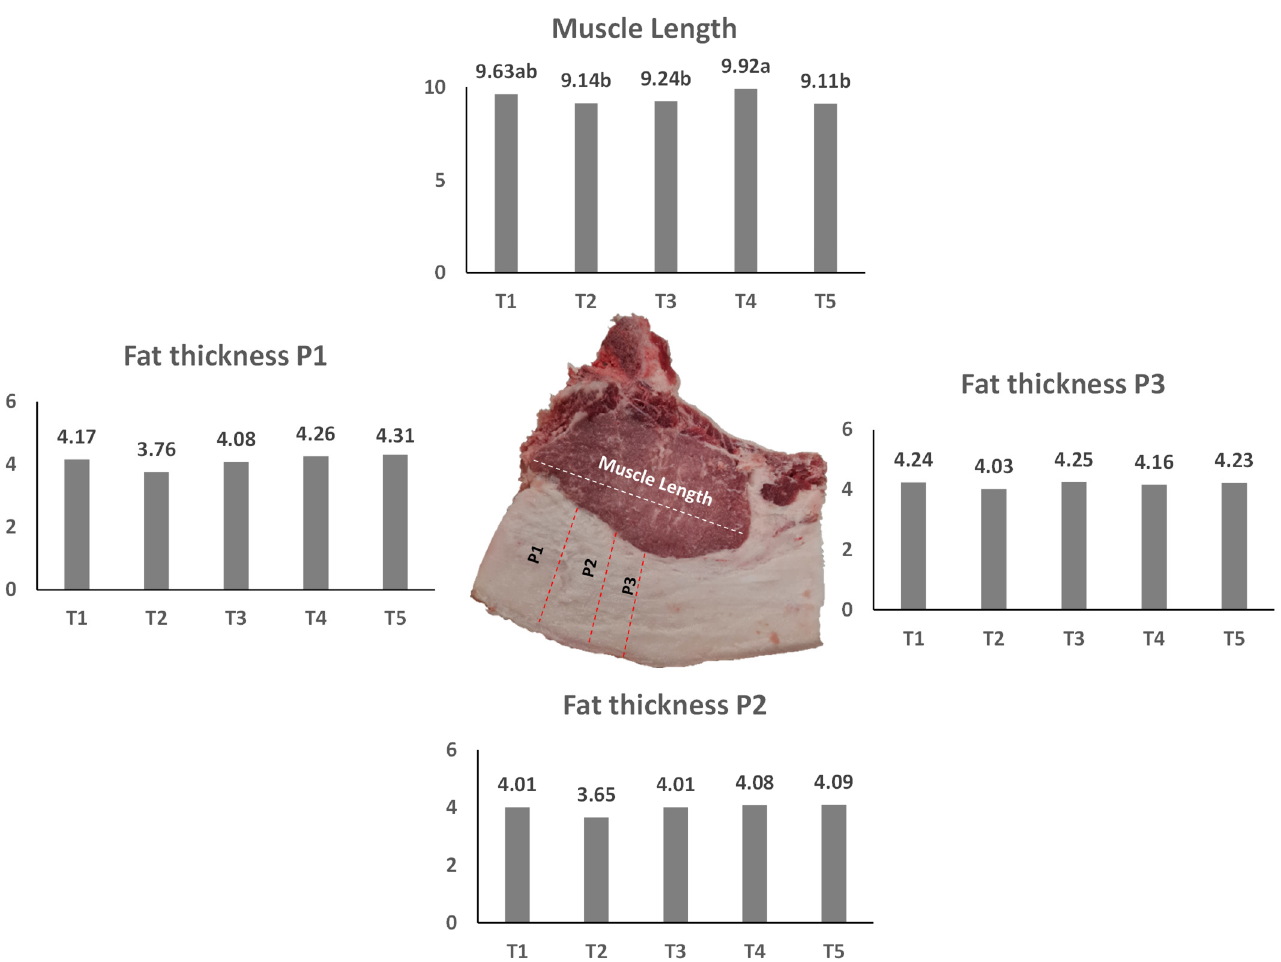
Figure 3. Muscle and backfat measurements at the 13th and 14th rib of Bísaro carcass (P1—4.5 cm from the dorsal midline; P2—6.5 cm from the dorsal midline; P3—8 cm from the dorsal midline). Mean values with different lowercase letters within the same treatment are significantly different ( p < 0.05). Mean values without letters have no significant differences ( p > 0.05). T1—Basic diet and commercial feed; T2—Basic diet + 10% crude olive cake; T3—Basic diet + 10% olive cake, two